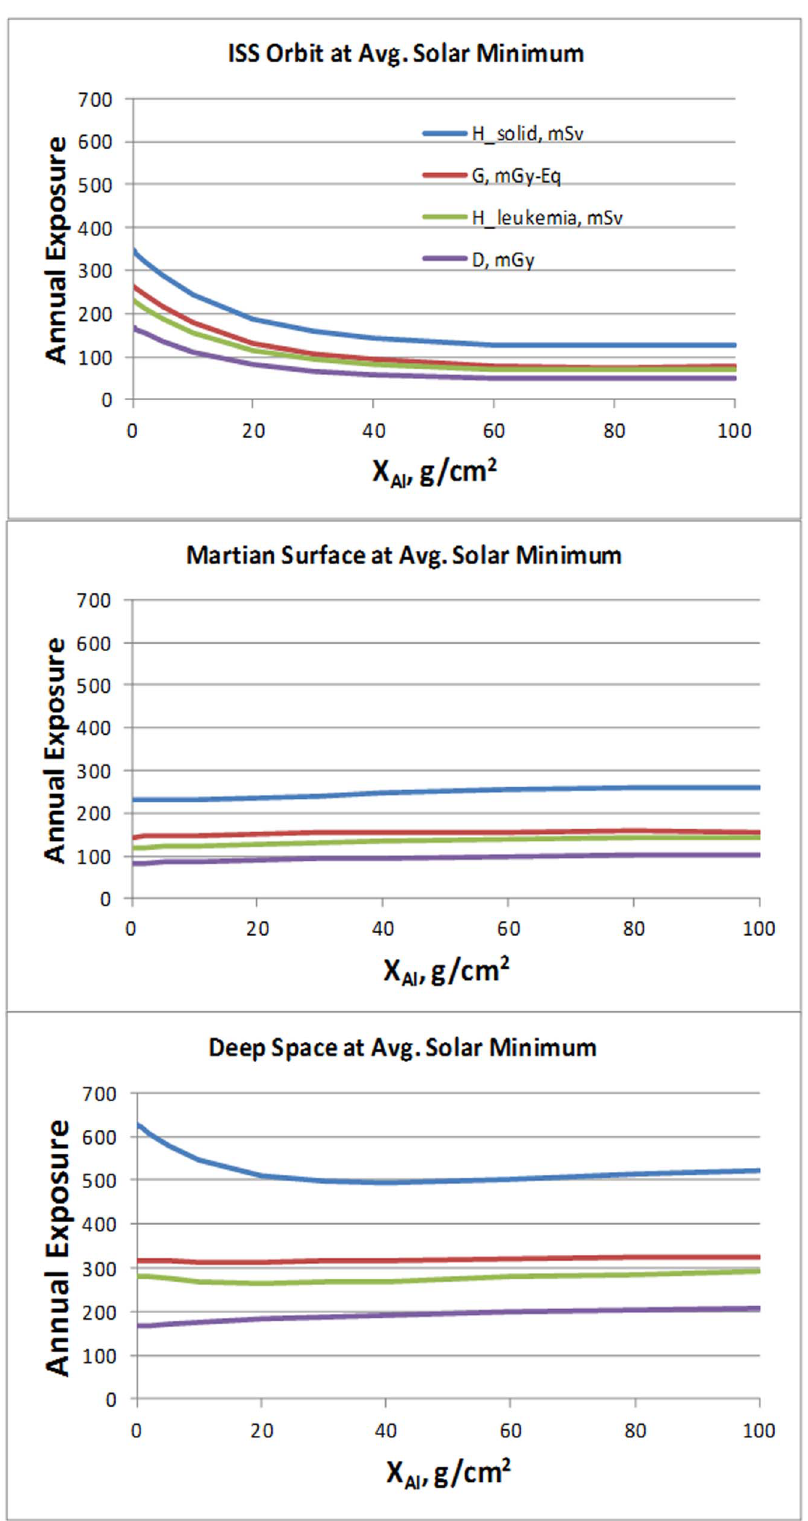
Figure 1. GCR organ dose characterization at average solar minimum. (A) The attenuation of annual GCR organ averaged doses versus depth of aluminum shielding for deep space, the martian surface, and for combined GCR and trapped protons in the ISS orbit. Calculations are for males absorbed dose (D) (mGy), solid cancer and leukemia risks (H) (mSv), and non-cancer effects (G) (mGy-Eq). Calculations on the martian surface consider its atmosphere with an 18 g/cm 2 CO 2 vertical height.